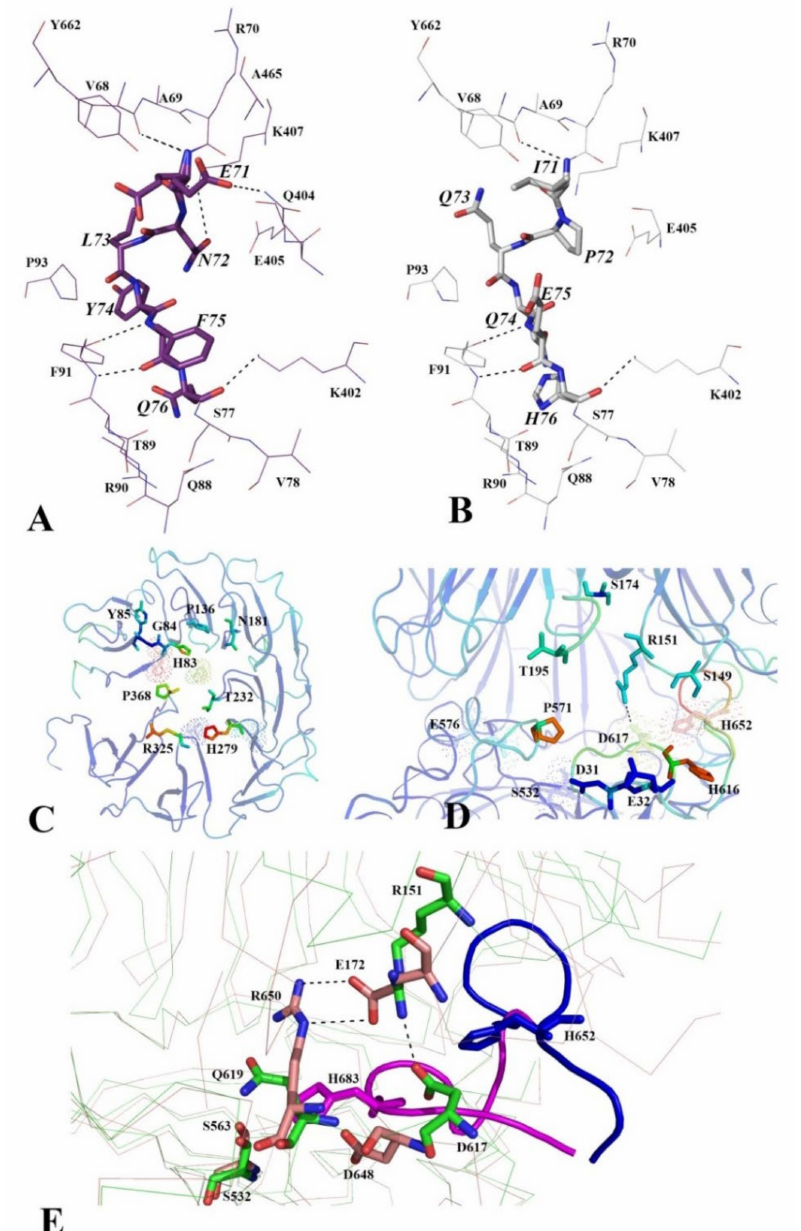
Figure 3. The modified hinge region, access to the interdomain cavity, and the configuration of the catalytic triad residues in the spatial structure of PSPmod. ( A ) The amino acid environment and polar contacts of the modified hinge region (shown in magenta). ( B ) Expected changes during the return of the original sequence of the hinge region (shown in grey). ( C ) A cartoon image of the entrance to the channel, which connects the upper part of the β -propeller domain with the cavity between the domains, and the amino acid residues, which limit the perimeter of the channel. The color change from blue to red reflects the shift of the B-factors from low to high. ( D ) A similar representation of the opening in the inter-domain interface and the amino acid residues that restrict the entrance to the opening. The catalytic triad residues and S1 substrate-binding center are represented by translucent dotted images. A dotted line shows the interaction between Arg151 and the catalytic Ser532. ( E ) Comparison of the configurations of the catalytic triads and salt bridges involved in the stabilization of the catalytic Asp positions in PSPmod (green) and closed state of TbOpB (beige). The His-loops are colored blue and purple for PSPmod and TbOpB, respectively. Amino acid residues are shown with sticks; salt bridges discussed in the text are marked with dotted